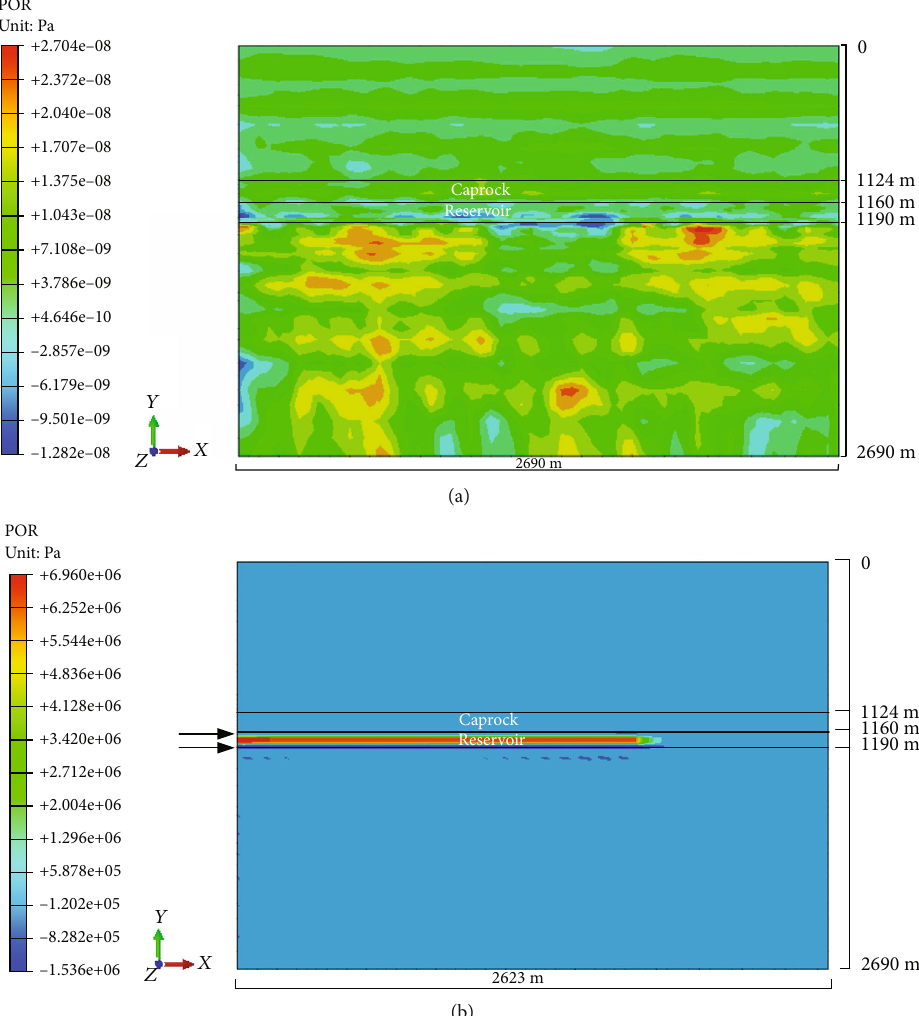
Figure 10: Variation nephogram of excess pore pressure. (a) Before injection. (b) After